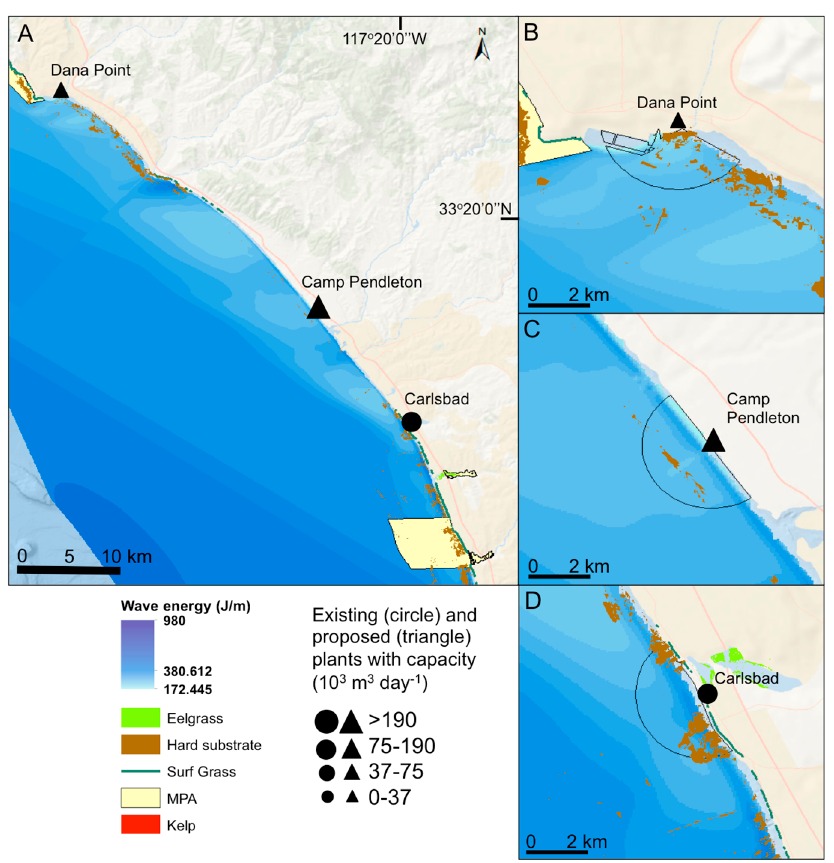
Figure 6. Average wave energy and benthic habitat for southern California with existing (circles) and proposed (triangles) desalination facilities ( A ). Zoomed perspective is shown in B – D .